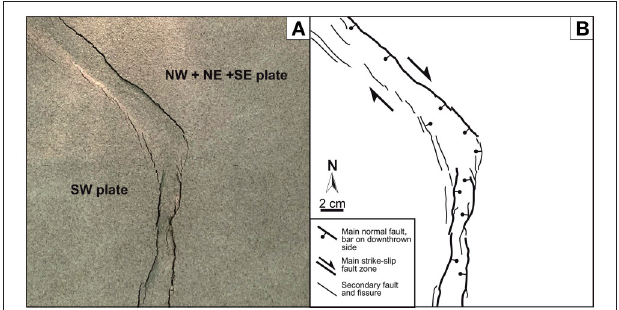
FIGURE 9 | (A) Photo of the experiment 2, made with only the NW and SW plates moving westward, and the other two plates fixed. (B) Sketch of the photo with indication of the main and secondary faults and extensional fractures. Note the development of the transform fault (HFF) with a right-lateral transtensional kinematics and of the complete GF both north and south of the junction (indicated by the arrow). This two-plate kinematics does not account for the interruption of the GF north of the junction and its bending, as well as of the other field structures located further to the